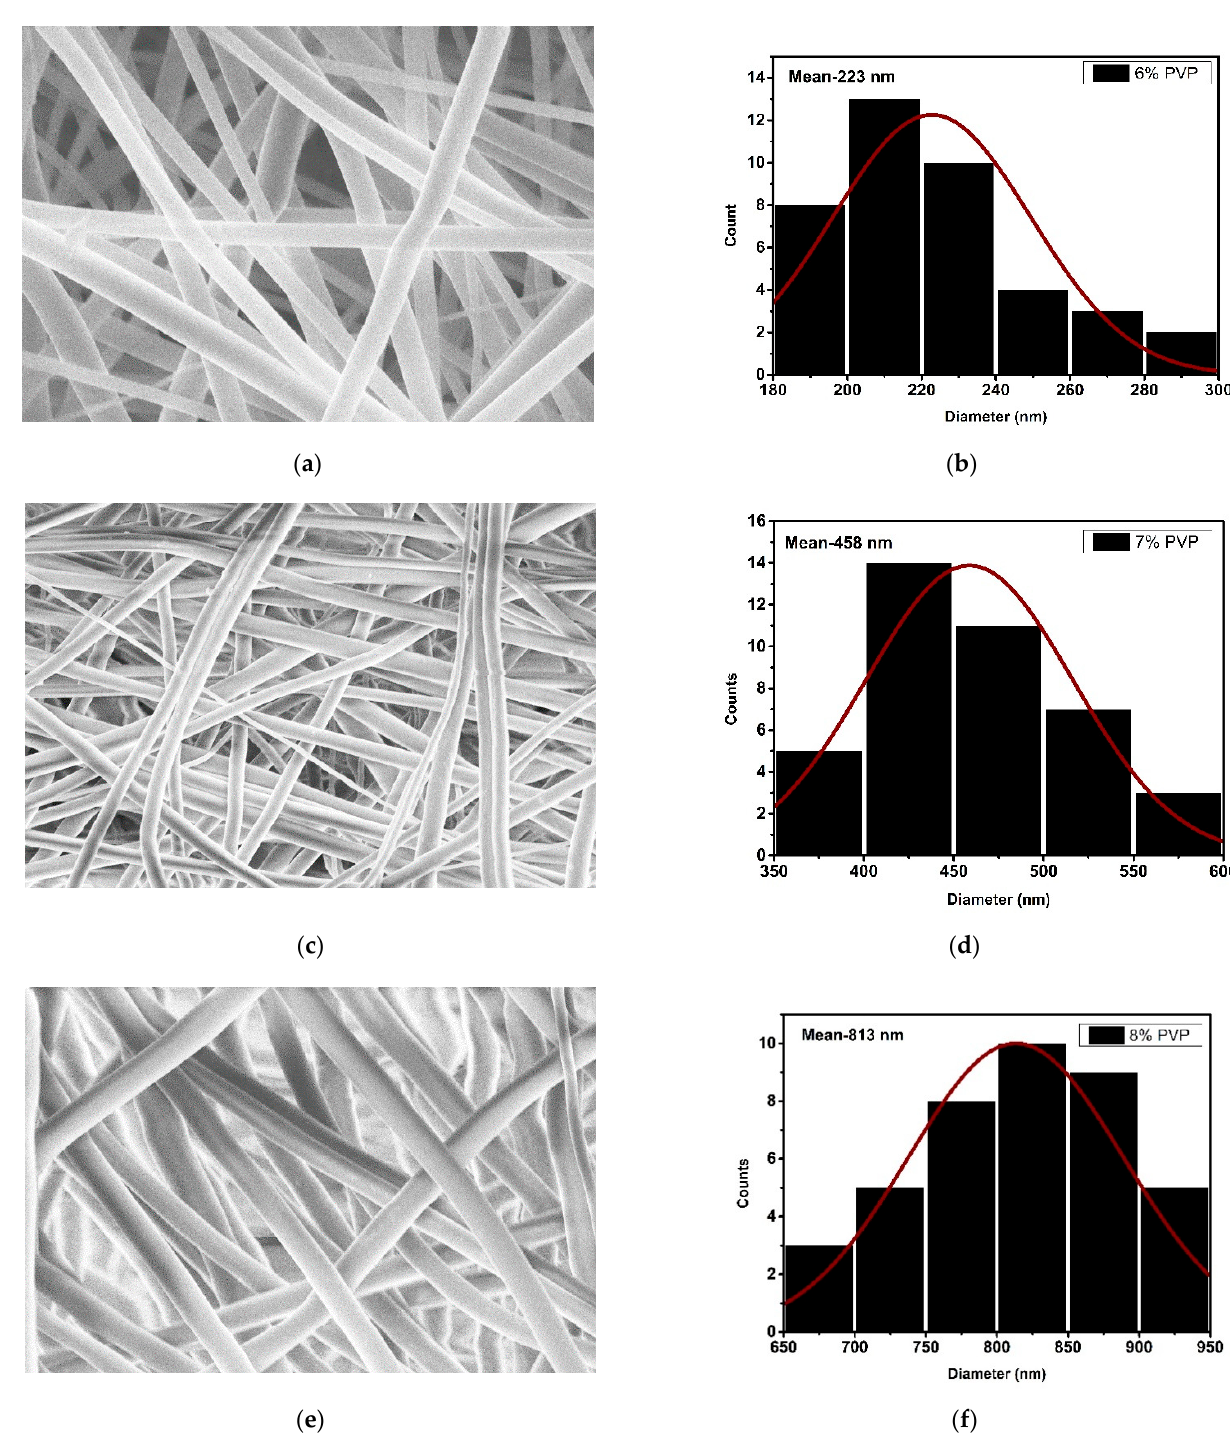
Figure 3. ( a , c , e ) represents FE-SEM images of ( i ) 6, ( ii ) 7 & ( iii ) 8 wt.% of PVP/TiO 2 nanofibers and ( b , d , f ) represent their corresponding diameter histograms.